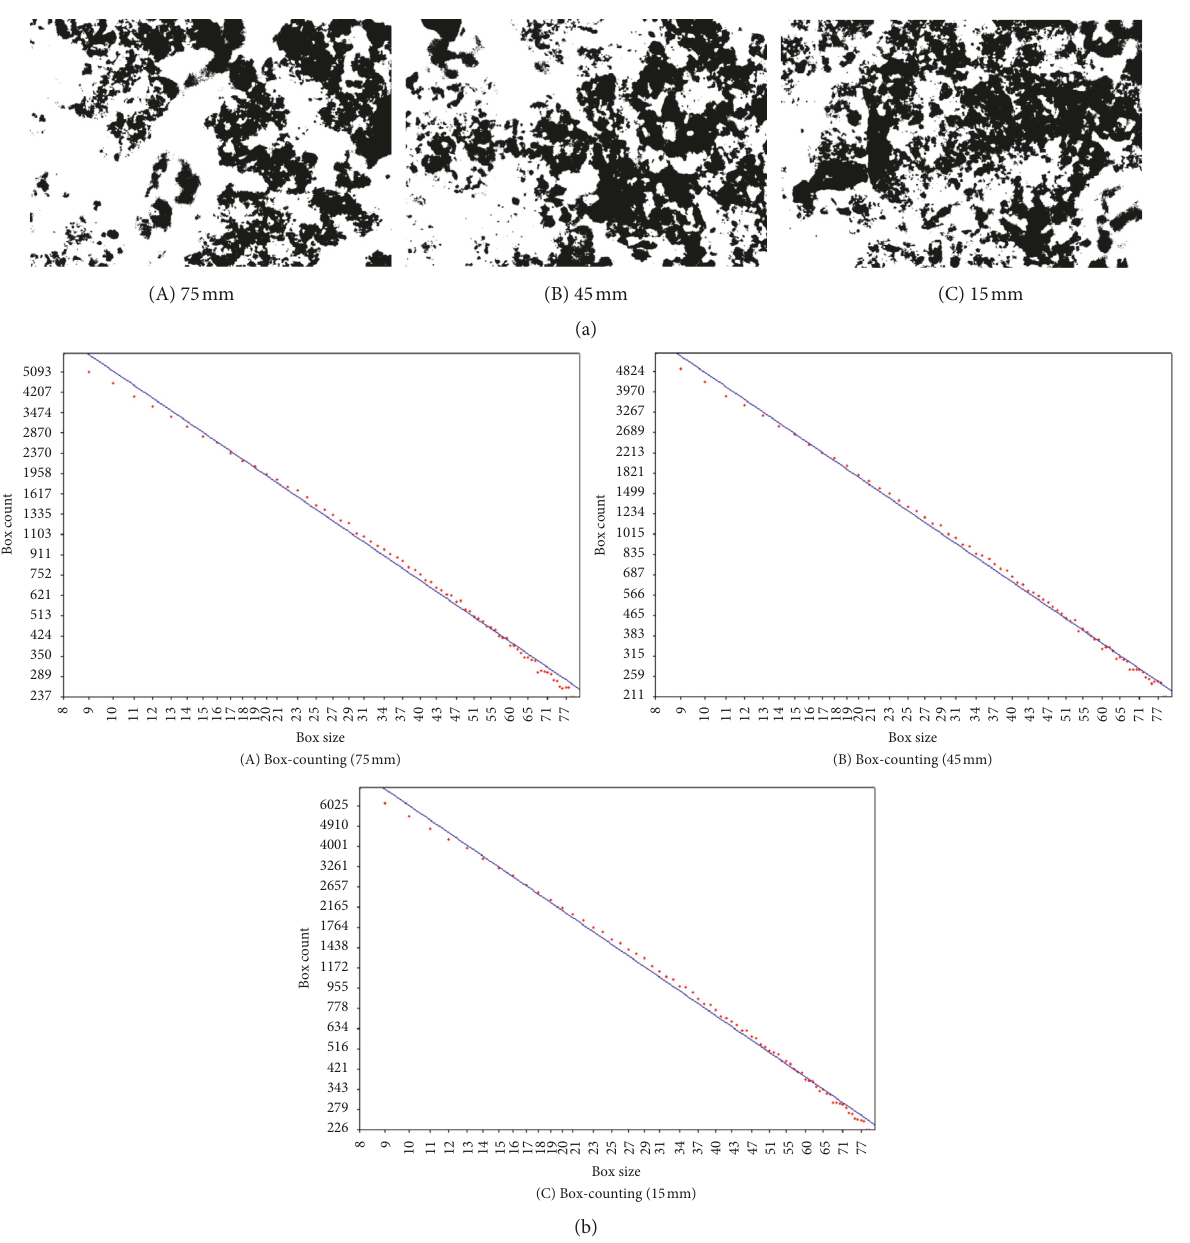
Figure 7: Aggregate fractal dimension of mud bed at different